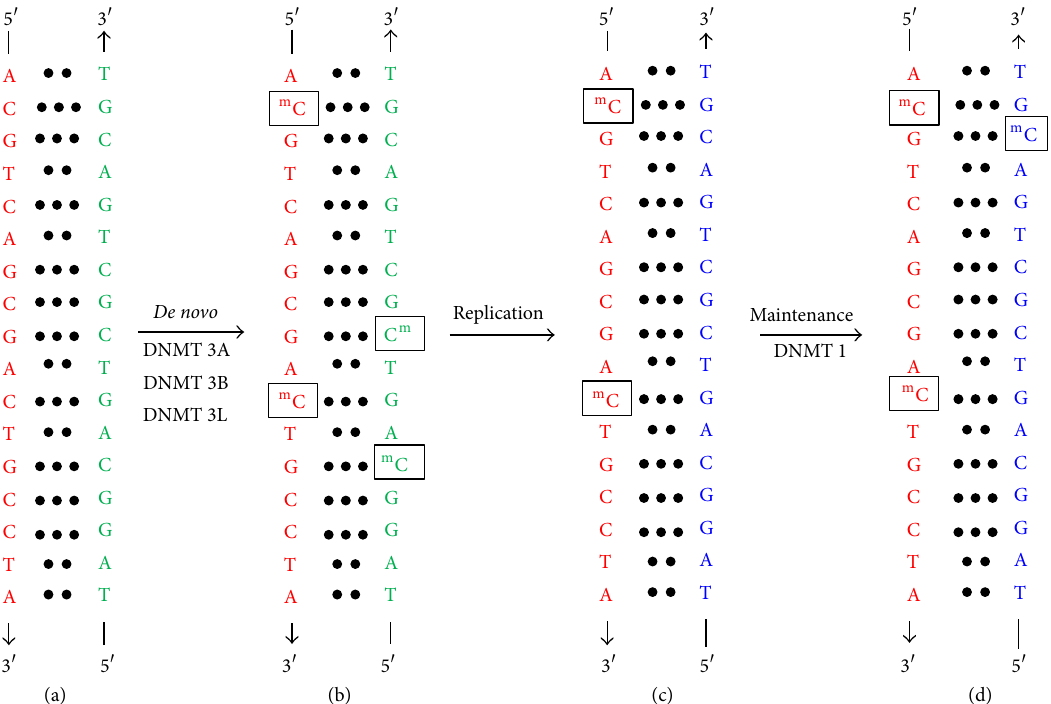
Figure 1: Specific roles of DNMTs in establishment and maintenance methylation in mammalian genomes. (a) Unmethylated DNA is acted upon by de novo methyltransferases DNMT3A and DNMT3B which methylated cytosines in the DNA molecule. The complementary strands are shown in green and red. This step also requires DNMT3L, the nonenzymatic member of DNMT family. (b) As a result of de novo methylation, methylated cytosines can be found in the context of both CpG and non-CpG dinucleotides. (c) After replication, the parental strand in each daughter DNA molecule serves as information for maintenance methylation. DNMT1 methylates cytosines in the daughter strand at positions that are exactly opposite to the methylated cytosines in the parent strand. (d) Because CpG dinucleotides are symmetric and exactly opposite in the daughter DNA, the maintenance methylation is highly efficient at CpG dinucleotides. Non-CpG dinucleotides do not contain cytosines at exactly the opposite positions in the two strands and therefore maintenance methylation in these dinucleotides is